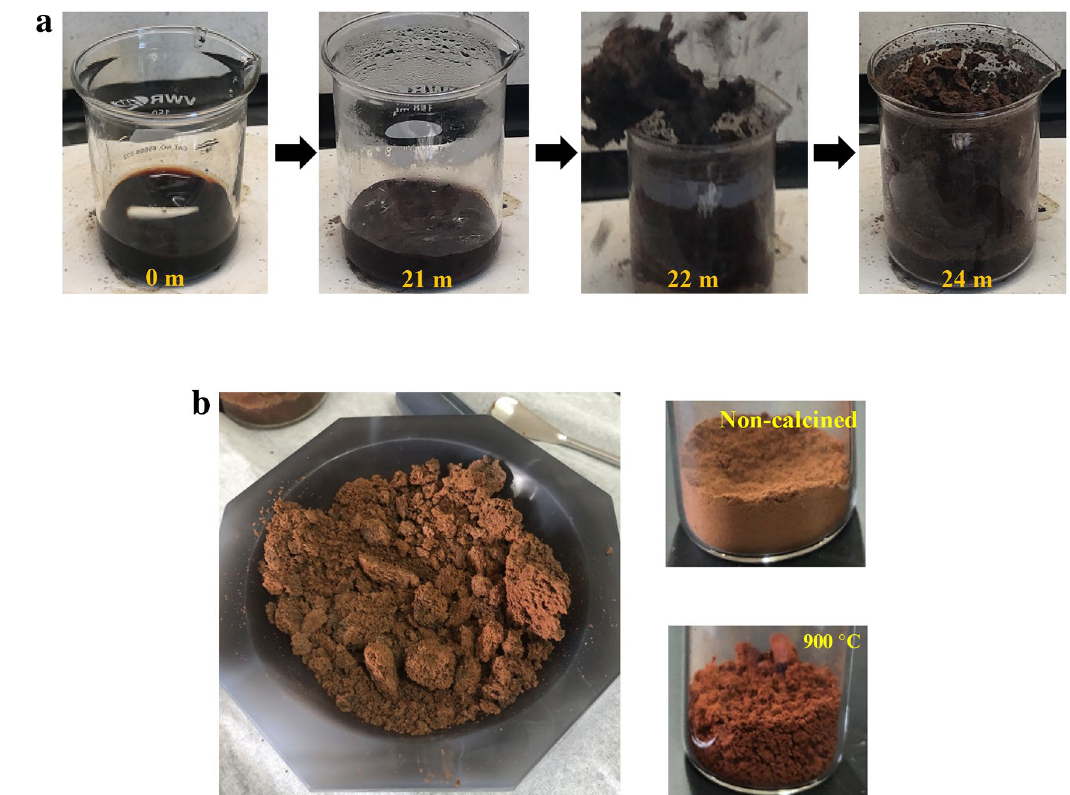
Figure 1. Preparation of porous CaFe 2 O 4 ( ϕ = 0.675) via Solution Combustion Synthesis: ( a ) timeline of synthesis by setting the hot plate surface temperature to 300 °C, ( b ) final product before grinding (left), after grinding (top-right), and after full calcination at 900 °C